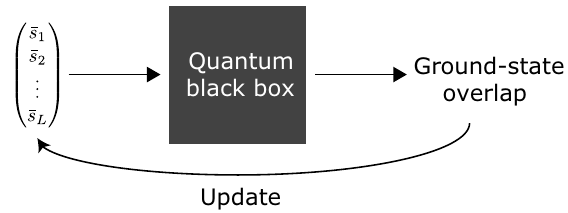
FIG. 6. The quantum-classical feedback loop for optimizing the chunk lengths of an adiabatic evolution while keeping the total time fixed. A parameter vector containing the chunk lengths is used as input for a quantum black box. The black box imple- ments an optimized adiabatic evolution accordingly and outputs the ground-state overlap. Making use of a classical optimizer, the chunk-length vector is updated in order to maximize the ground-state